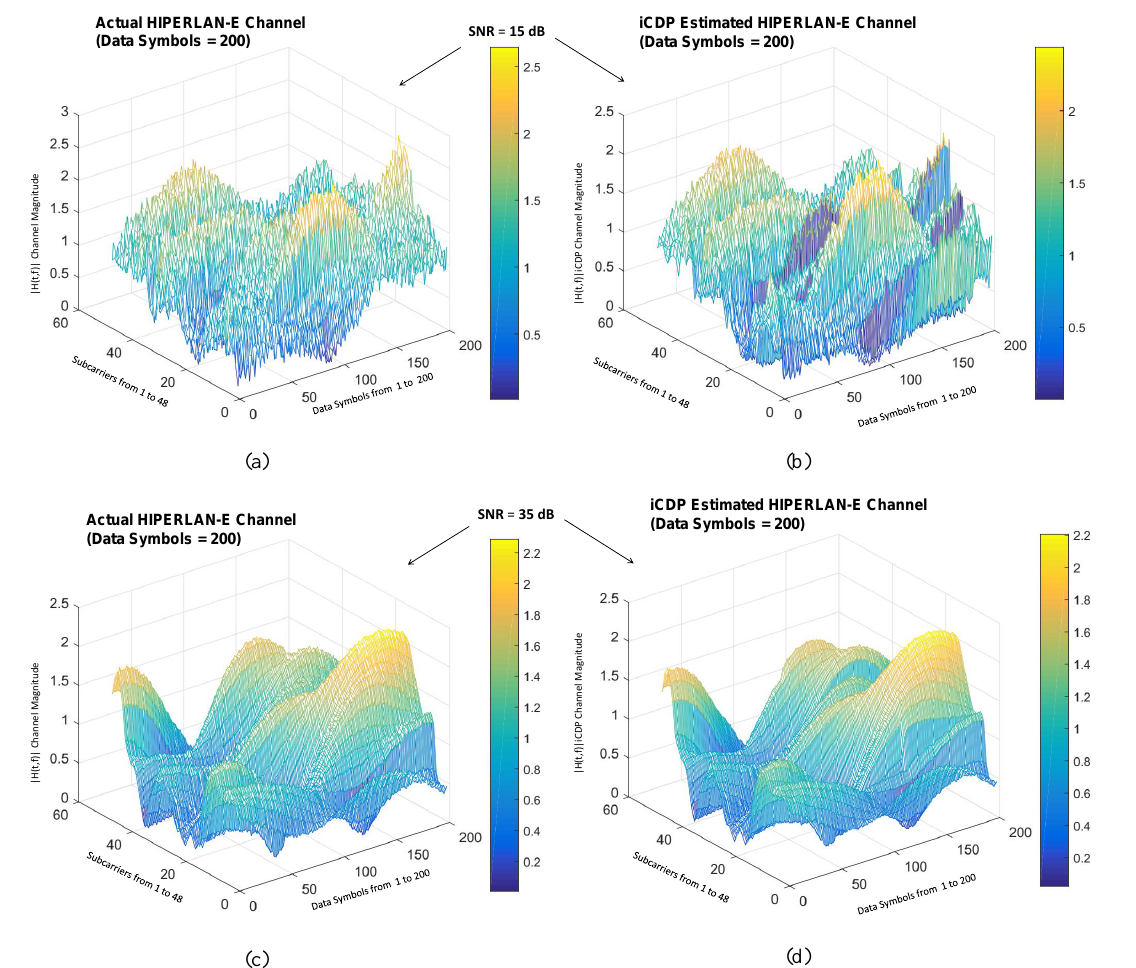
Figure 10. Actual and Estimated HIPERLAN-E channels: ( a ) Actual channel at SNR = 15 dB. ( b ) Estimated channel at SNR = 15 dB. ( c ) Actual channel at SNR = 35 dB. ( d ) Estimated channel at Signal-to-Noise Ratio (SNR) = 35 dB.